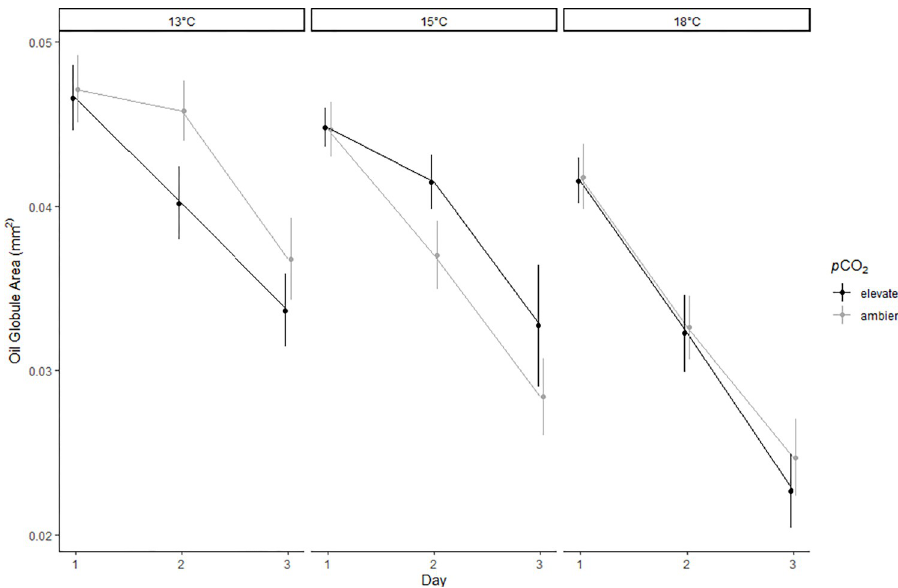
Fig 3. Larvae oil globule usage. Oil globule area of surf smelt larvae (n = 144/day) that were submerged in treatment water for 3 days. Each point is an average measurement representative of the temperature treatment, p CO 2 treatment (points offset for visualization), and day with standard error shown as whiskers. Day, and Temperature were significant factors predicting larvae oil globule usage.